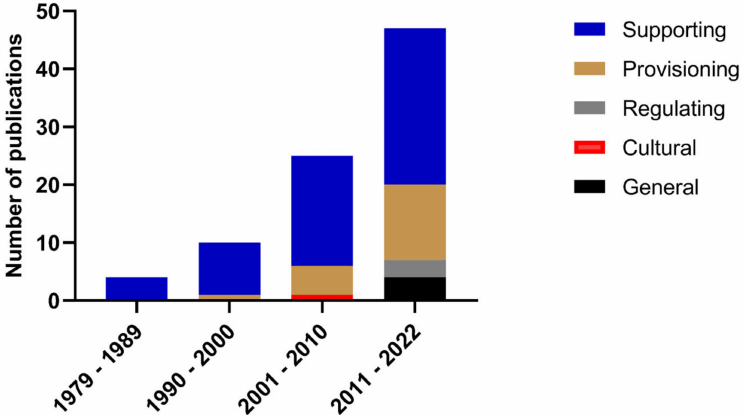
Figure 2. Number of publications per